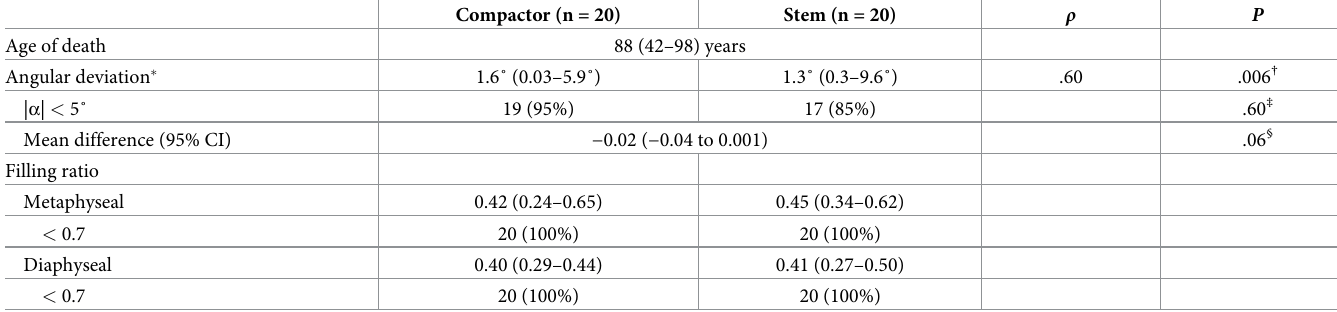
Table 2. Patient (cadaver) age and measured implant variables for short humeral stems implanted with standard-length